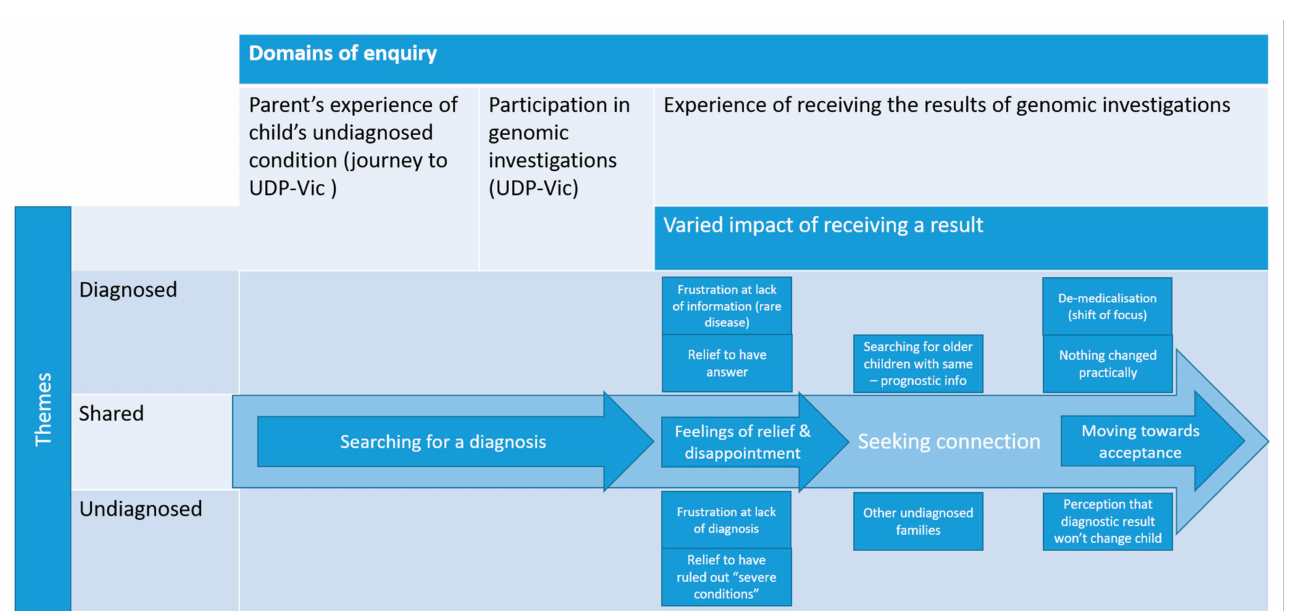
Figure 1. Comparison of parental experiences across both